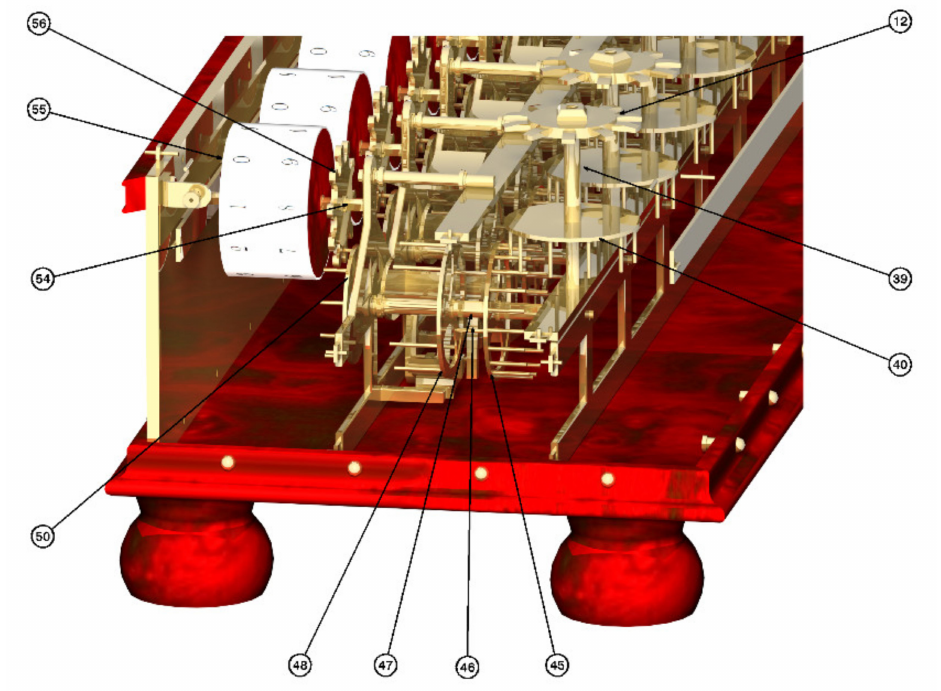
Figure 6. Zoomed representation of the mechanism showed in Figure